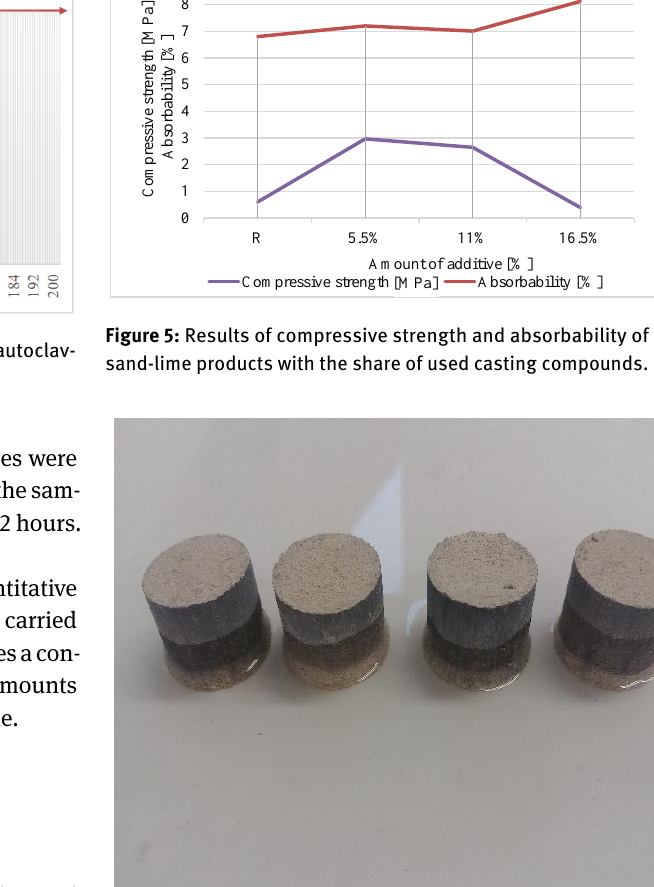
Figure 6: Testing of the absorbability of